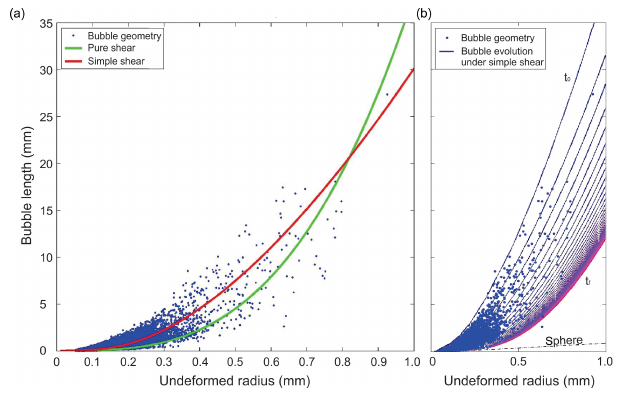
Figure 8. Bubble geometry population and shear models. Bub- ble geometry distribution compared to (a) the best fit for simple (red) and pure shear (green). (b) The fitting curves for simple shear evolving using our constraints of the characteristic cooling rate of 10 − 4 . 9 s − 1 and a strain rate of 10 − 2 s − 1 . Applying a cooling rate profile across the sample explains the data distribution. The best fit for pure shear requires a nonphysical, infinitely fast, cooling rate; a realistic cooling rate pushes the modelled bubble length to below the imaged population, rejecting the possibility that pure shear in- duced the porous structure of the tube